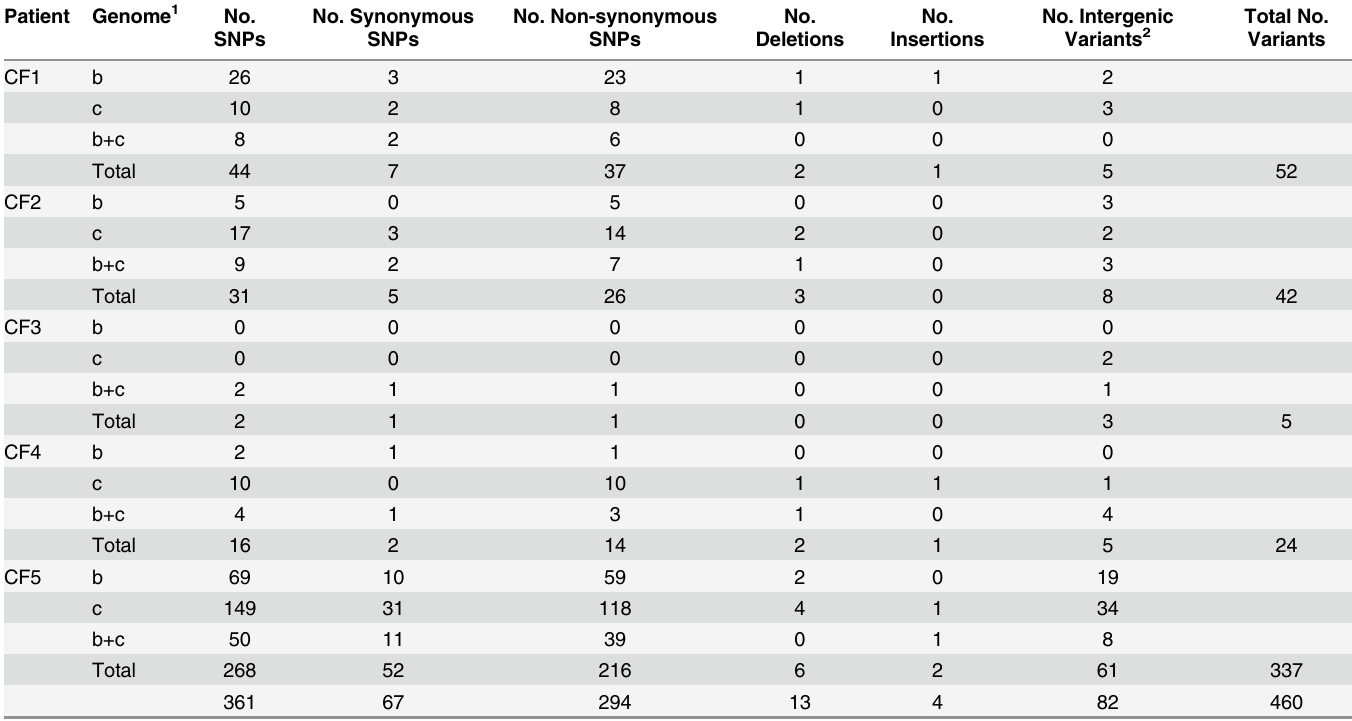
Table 3. Number of detected mutations.